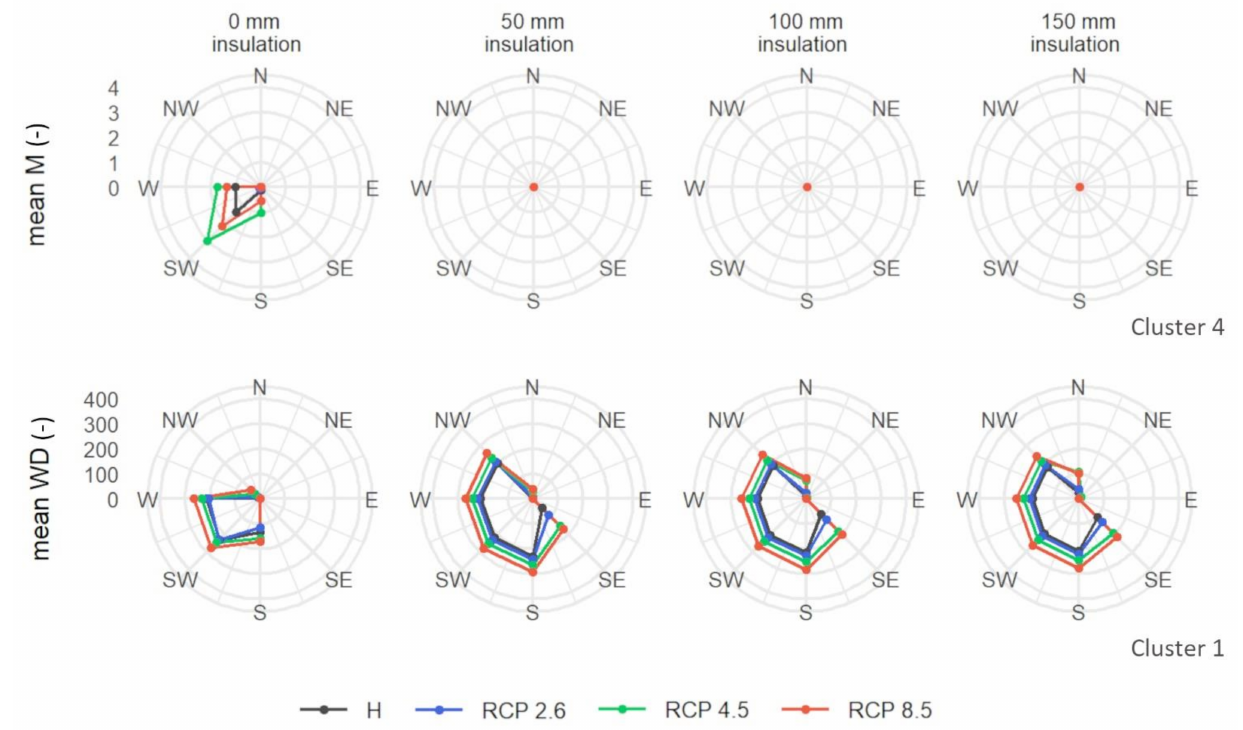
Figure 4. Mean M for the 300 mm masonry wall of cluster 4 ( top ) and mean wood decay (WD) for the 300 mm masonry wall of cluster 1 ( bottom ) per orientation for the historical period (H) and RCP projections. The uninsulated wall and 3 insulated walls with varying thicknesses are presented for rain exposure coefficient = 2.0.